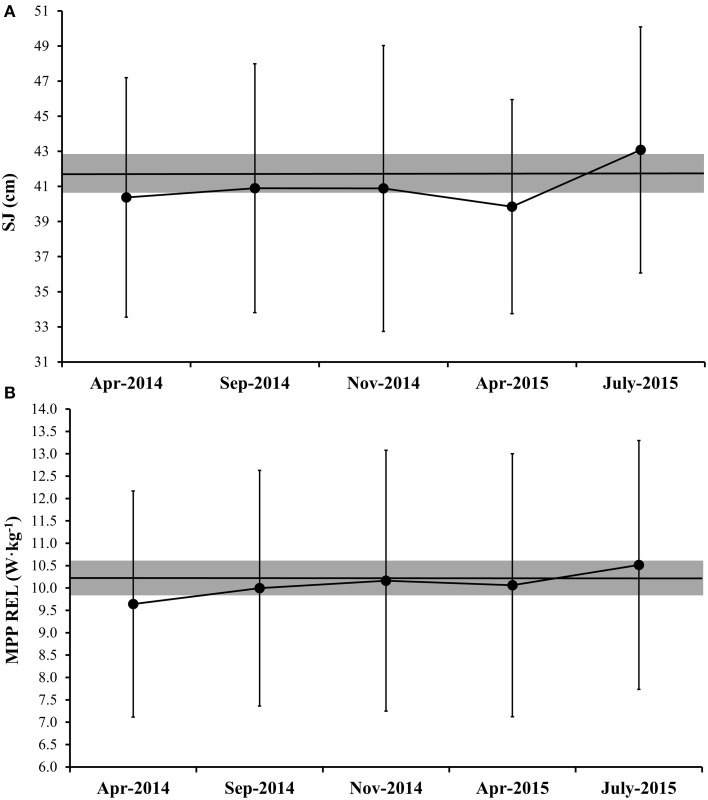
Variation in squat jump (SJ) (A) and relative mean propulsive power in jump squat exercise (MPP REL JS) (B) test results across the five periods. The black line represents the mean individual performances, and the gray area represents the smallest important effect on performances (i.e., calculated as half of the within-athlete test-to-test variability).